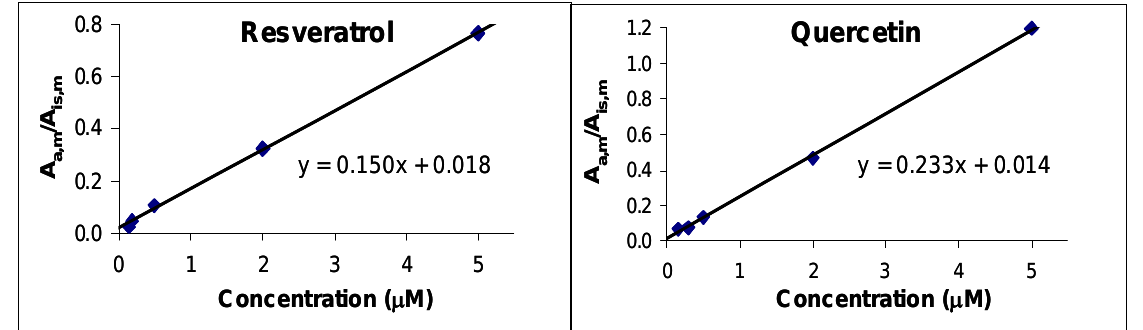
Figure 1. Linear regression of the ratio of the peak area of (a) resveratrol and (b) quercetin (at 320 and 370 nm, respectively) to that of their standards (at 286 and 370 nm, respectively) as a function of the concentration of the former.